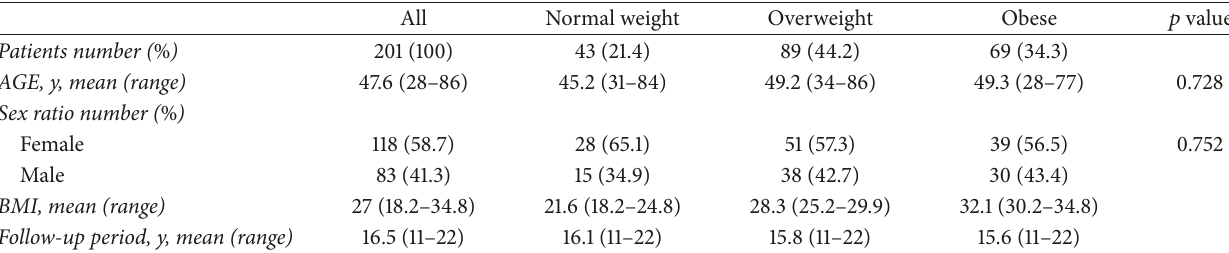
Table 1: Baseline characteristics of patients.